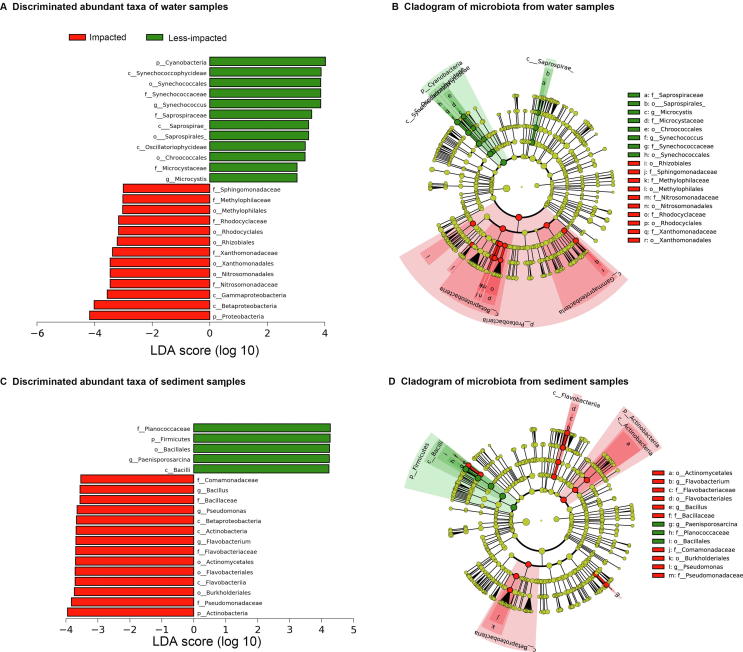
Biomarker analysis of water and sediment microbial communities from impacted and less-impacted sitesA. Differentially abundant taxa of water samples. B. Cladogram showing the phylogenetic structure of the microbiota from water samples. C. Differentially abundant taxa of sediment samples. D. Cladogram showing the phylogenetic structure of the microbiota from sediment samples.